Question: What does this figure show? Answer in one sentence.
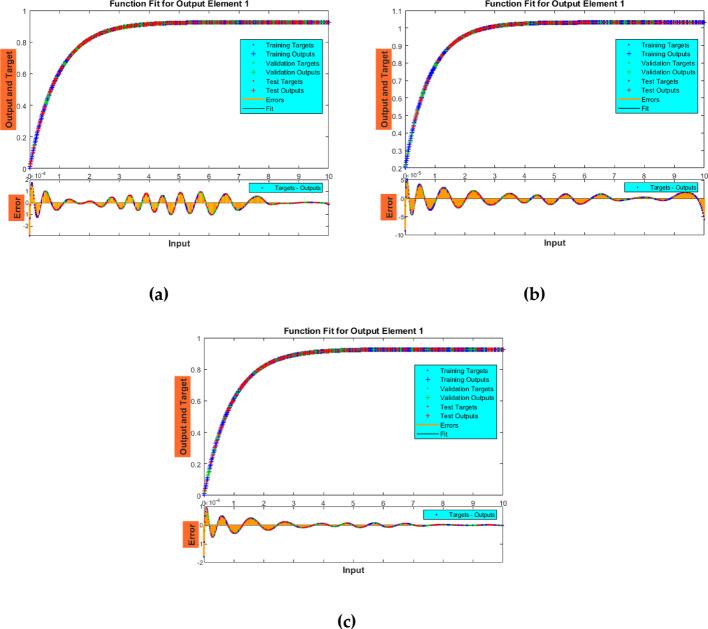
Answer: a-c Curve fitting for ANN design (Scenarios 1–3)